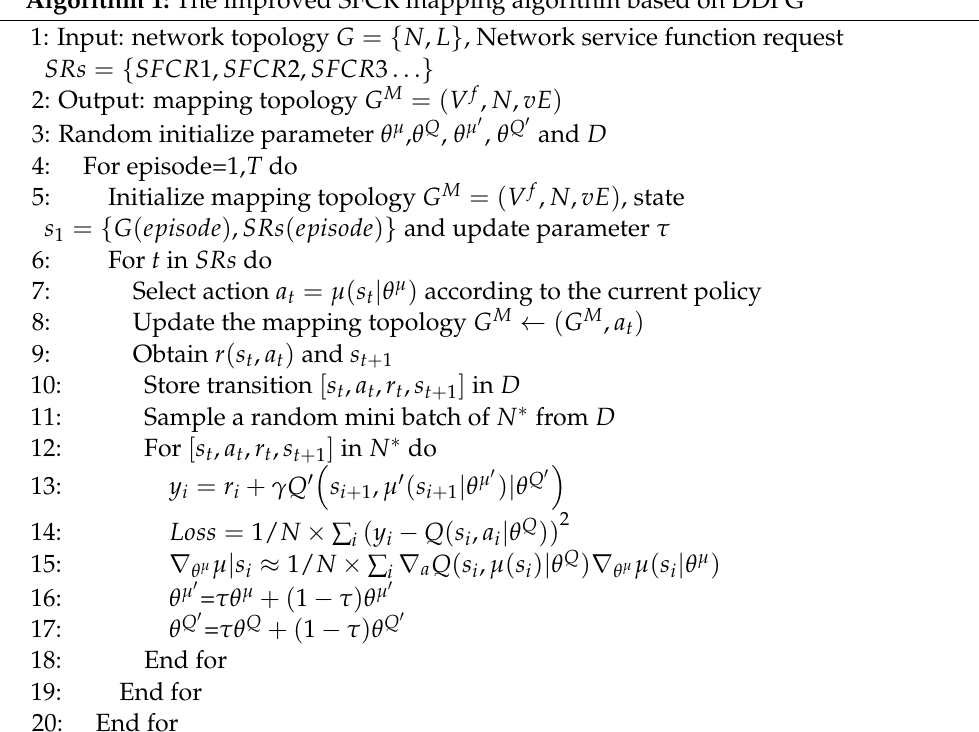
Algorithm 1: The improved SFCR mapping algorithm based on